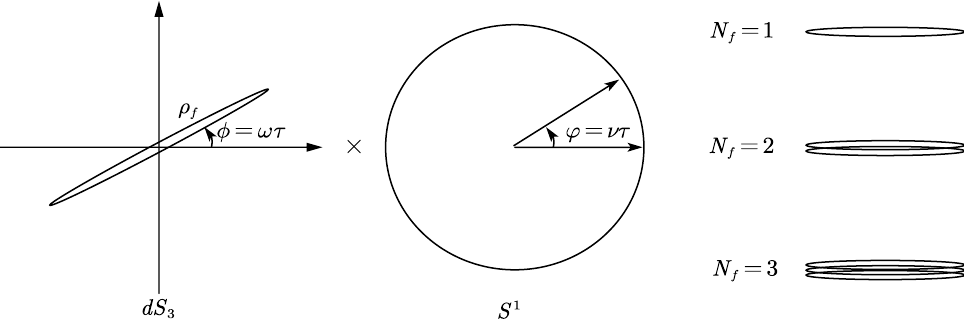
Figure 2 . Illustration of ω , ν and N f : ω is the angular velocity in the φ direction. ν is the angular velocity in the ϕ direction. N is the folding f